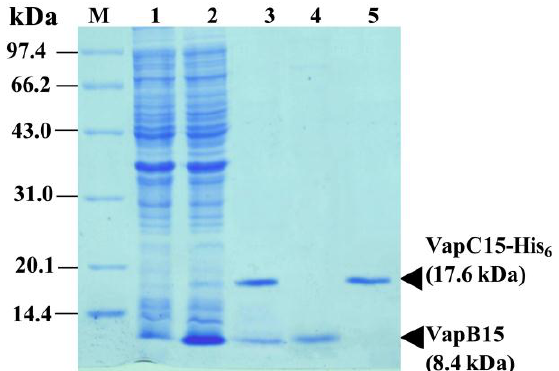
Figure 2. Sodium dodecyl sulfate-polyacrylamide gel electrophoresis (SDS-PAGE) analysis for the recombinant proteins from the isopropy-β- D -thiogalactoside (IPTG)-induced cells of E. coli BL21(DE3)(pJS666). M , protein molecular weight standard; 1 , uninduced cells; 2 , IPTG-induced cells; 3 , Co-purified proteins by Nickel-Nitriloacetic Acid (Ni-NTA) affinity chromatograph under native conditions; 4 and 5 , Purified and renatured proteins VapB15 and VapC15-His 6 , respectively.